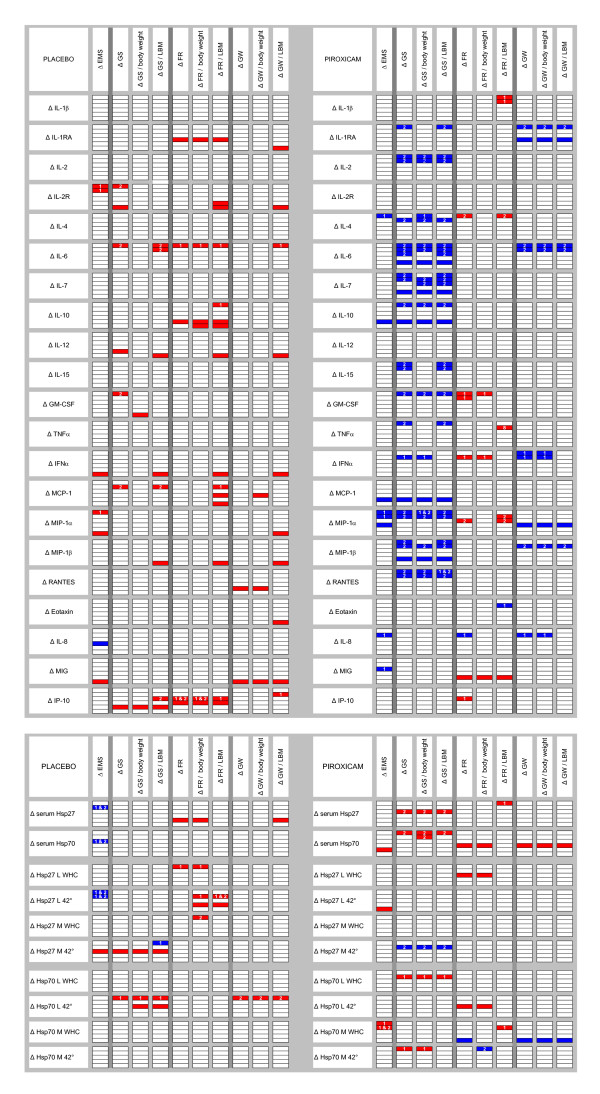
Spearman's rho correlations between changes in cytokines (Figure 4a) or changes in extra-and intra-cellular Hsp (Figure 4b) and changes in muscle parameters (raw data as well as results corrected by kg body weight and by kg lean body mass). Significant correlations with p < 0.05 (two-sided) are indicated in red when positive, in blue when negative. Serum levels of cytokines and Hsp were measured at 6 follow-up time-points (changes to baseline indicated by 6 rectangles for each cytokine in each column). Intracellular Hsp were measured at 5 follow-up time-points (changes to baseline indicated by 5 rectangles for each). Muscle parameters were evaluated at 3 follow-up time-points. Correlations were computed between early changes (first days) in cytokines or Hsp and changes in muscle parameters at week 1 and 2. When correlations with these early changes were significant, white numbers in the corresponding rectangle indicate the corresponding time-point of the concerned muscle parameter. The lower three rectangles indicate the concomitant changes compared to baseline at weeks 1, 2 and 3 for both parameters concerned.